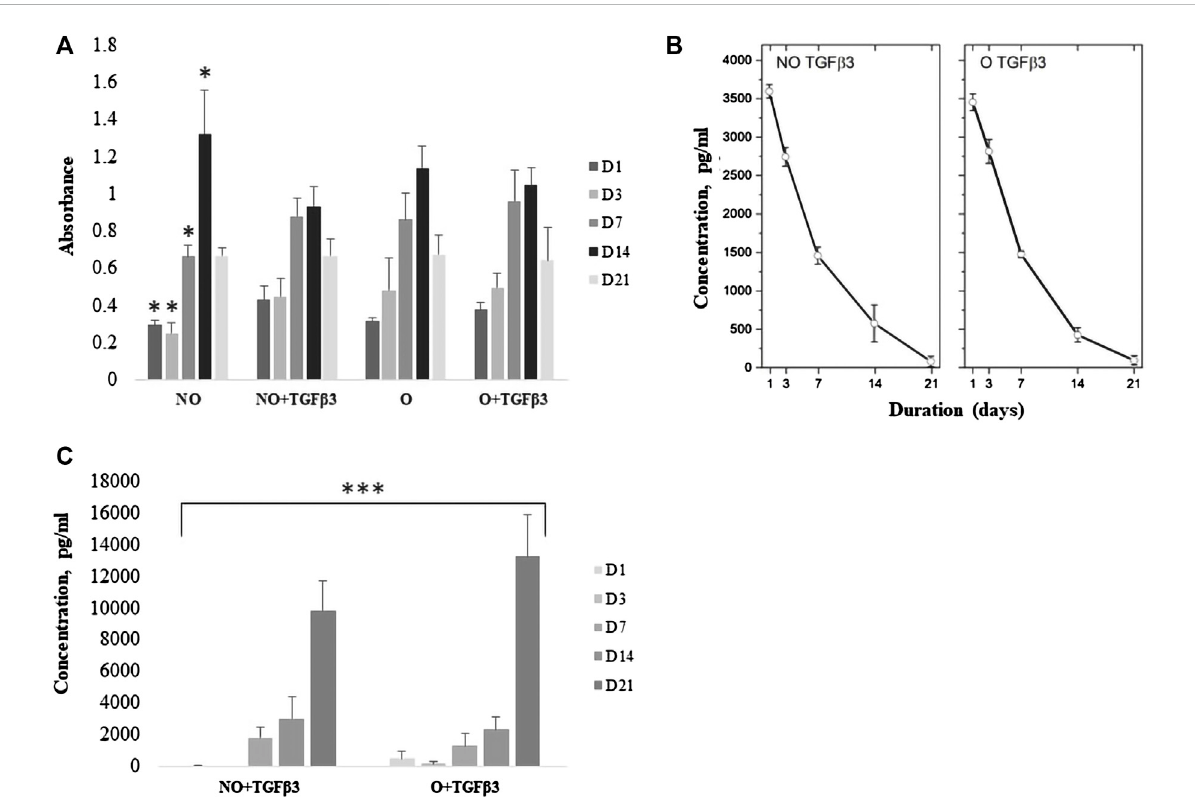
FIGURE 3 Cell proliferation within scaffolds (A) , TGF β 3 release from scaffolds with rMDSCs (B) and collagen-II (Coll2) protein production from ozone- treated and untreated scaffolds with loaded TGF β 3 (C) . The cell proliferation rate was tested on days (D) 1, 3, 7, 14, and, 21 via CCK-8. TGF β 3 and collagen-II protein levels were tested at the same time-points via ELISA. Results are presented as mean ± standard deviation. * represents p -value < 0.01 comparing NO at D1, 3, and 7 to NO loaded with TGF β 3 and O with or without TGF β 3. p -value < 0.01 also belongs to NO D14 compared with NO loaded with TGF β 3 (A) . *** represents < 0.001 p -value; the Kruskal – Wallis test showed a signi fi cant difference between multiple time-points (D1 – D21) compared to NO and O scaffolds loaded with TGF β 3 in Coll2 protein analyses (C) . NO-untreated; O,